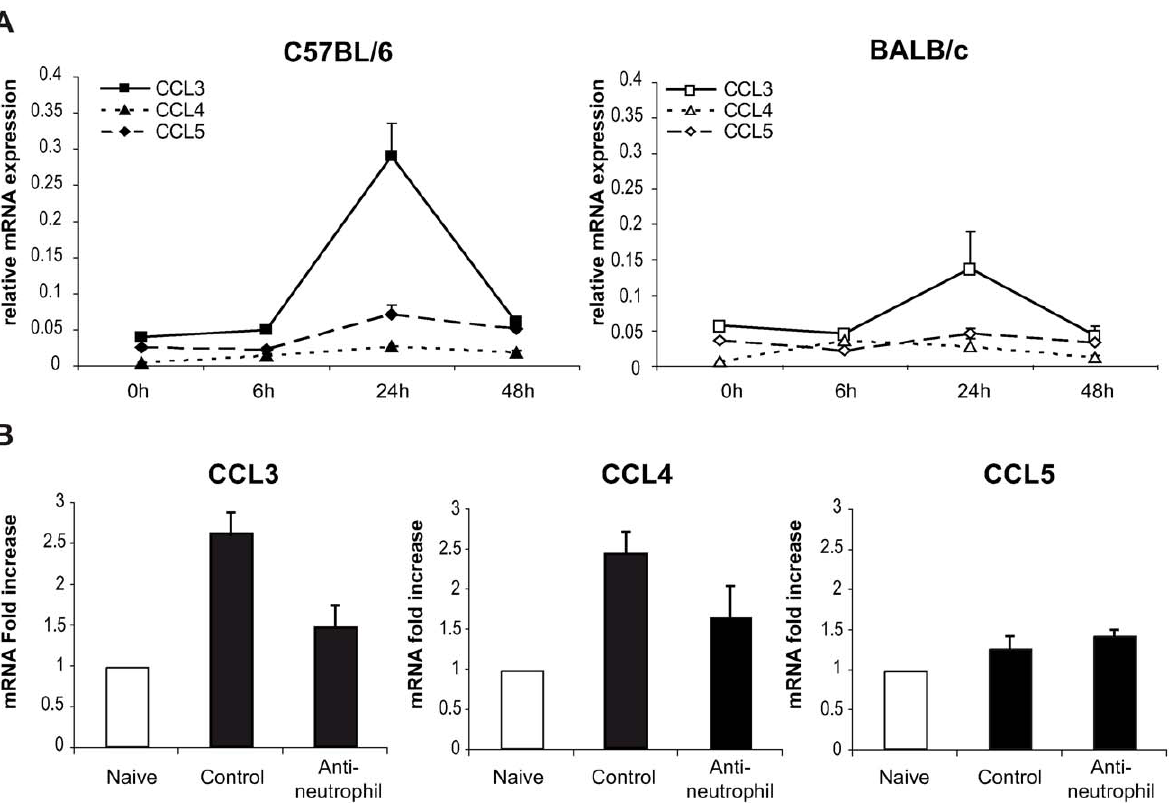
Figure 4. CCL3 is a major DC-attracting chemokine in the ear dermis one day post L.major inoculation. (A) C57BL/6 and BALB/c mice were infected with L. major in the ear dermis. mRNA expression of CCL3, CCL4 and CCL5 at the site of infection was measured 0, 6, 24 and 48 hours post infection by quantitative Real-time PCR and normalized relative to HPRT mRNA levels. Data are represented as the mean 6 SEM mRNA transcript levels of individual infected ear (n=6 per time point). One representative experiment of three is shown. (B) Twenty four hours post-infection, the ear chemokine mRNA level was compared in C57BL/6 mice that were given either the NIMP-R14 neutrophil depleting mAb or a control mAb 6 hours prior to L. major inoculation in the ear. Results are represented as fold increase in mRNA levels relative to levels measured in uninfected mice given a value of 1, and are representative of two experiments.